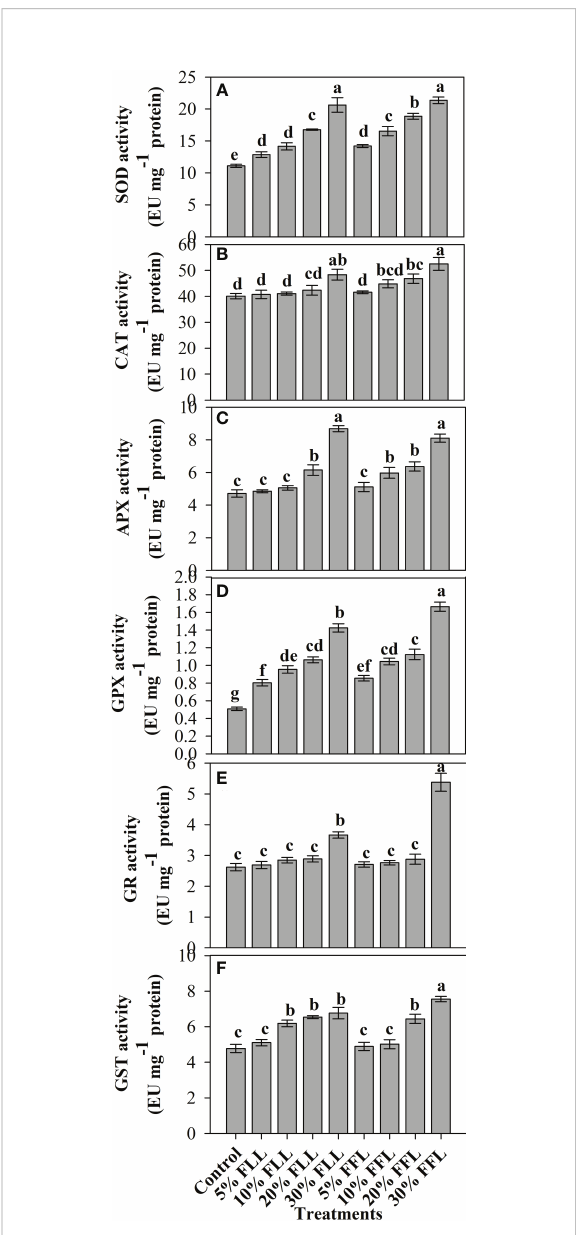
FIGURE 6 Superoxide dismutase, catalase, ascorbate peroxidase, guaiacol peroxidase, glutathione reductase, and glutathione S-transferase (EU mg -1 protein) activity (A – F) in leaves of Triticum aestivum L. plants raised using sand substrate (25 DAS) treated with leachates of fresh leaves and fl owers of Tagetes erecta L. Data followed by the same letters are not signi fi cantly different at p<